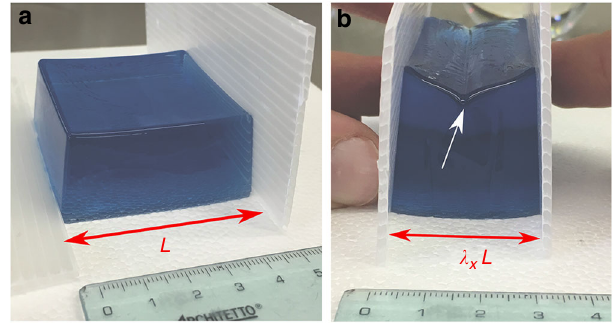
Fig. 1 Crease formation in a compressed soft slab. a A 5 × 5 × 2 cm 3 soft block is made by mixing 37.2 mL of deionised water containing Blue Dextran (1 mg/mL) with 16 mL of 0.5 M Tris – HCl buffer at pH 6.8, and 8.75 mL of a solution containing Acrylamide (30% w/v) and Bis-acrylamide (0.8% w/v) in a soft silicone-based mould. In total 625 μ L of APS